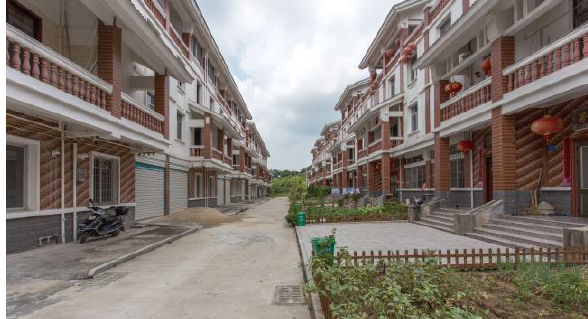
Figure 14. Example of a rural development: Jiankou Happy community, Putian City, Fujian Province. Photo by the first